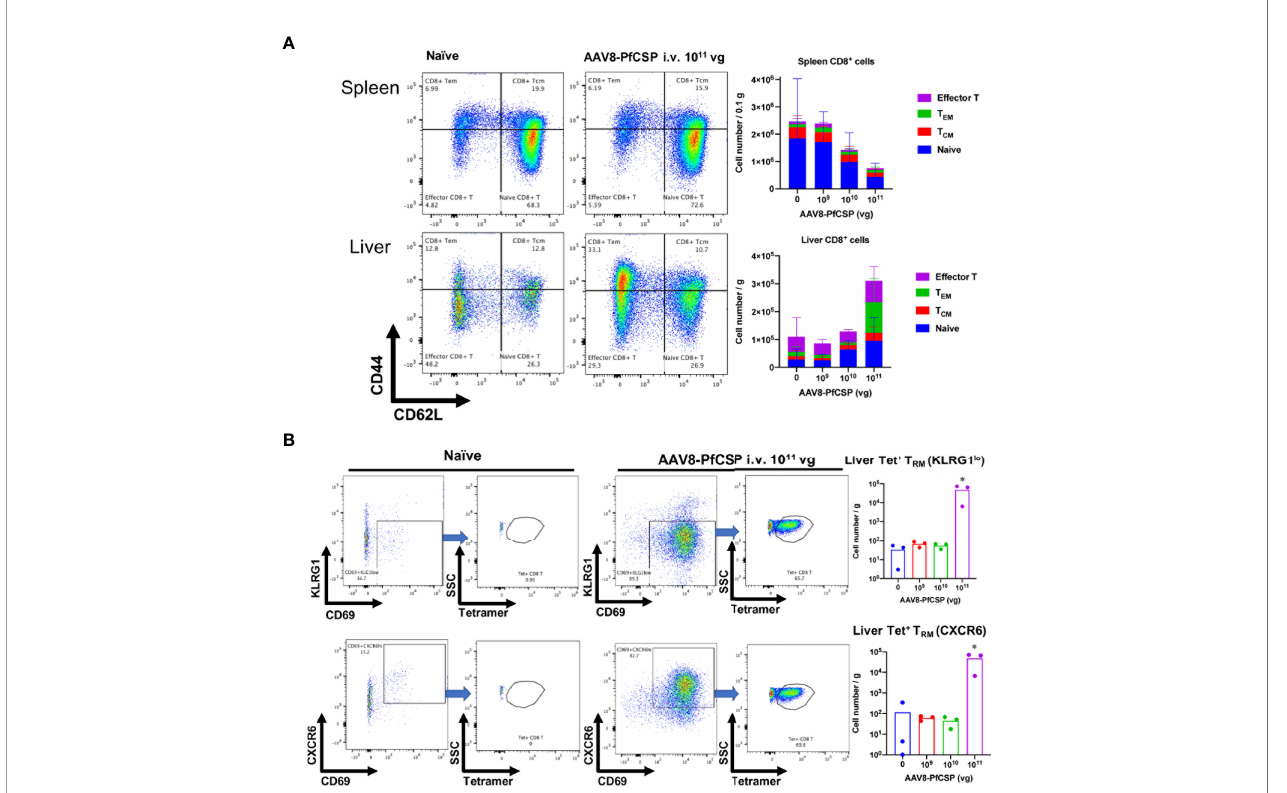
FIGURE 7 | T-cell responses in the liver and spleen after i.v. immunization with AAV8. Mice were immunized with AAV8-PfCSP (n = 3 per group; 1.0 × 10 9 , 1.0 × 10 10 , or 1.0 × 10 11 vg) or PBS via i.v. administration into their tail veins. After 2 weeks, the CD8 + T cells collected from the livers and spleens were stained as described in the Materials and Methods. Gated CD45 + CD8 + T-cells in livers ( A , lower panels) or spleens ( A , upper panels) were analyzed for CD62L and CD44 expression. The mean absolute numbers of the spleen or liver CD8 + T cells are shown in the right-hand graphs. (B) Flow cytometric measurement of CD69 + and KLRG1 lo ( B , upper panels) or CXCR6 + ( B , lower panels) tetramer-stained, CSP-speci fi c liver T RM cells in the CD45 + CD8 + CD62L lo CD44 hi T EM population. Mean absolute numbers of the spleen or liver PfCSP-speci fi c CD8 + T RM cells are shown in the right-hand graphs. * p < 0.05 by one-way nonparametric ANOVA (Kruskal – Wallis) followed by the Dunn multiple comparisons